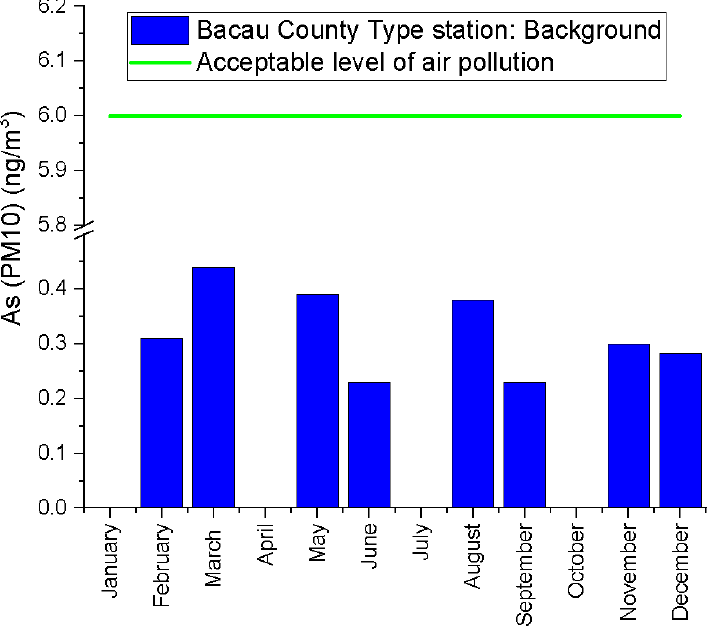
Figure 17. Average As concentration in the year 2020.